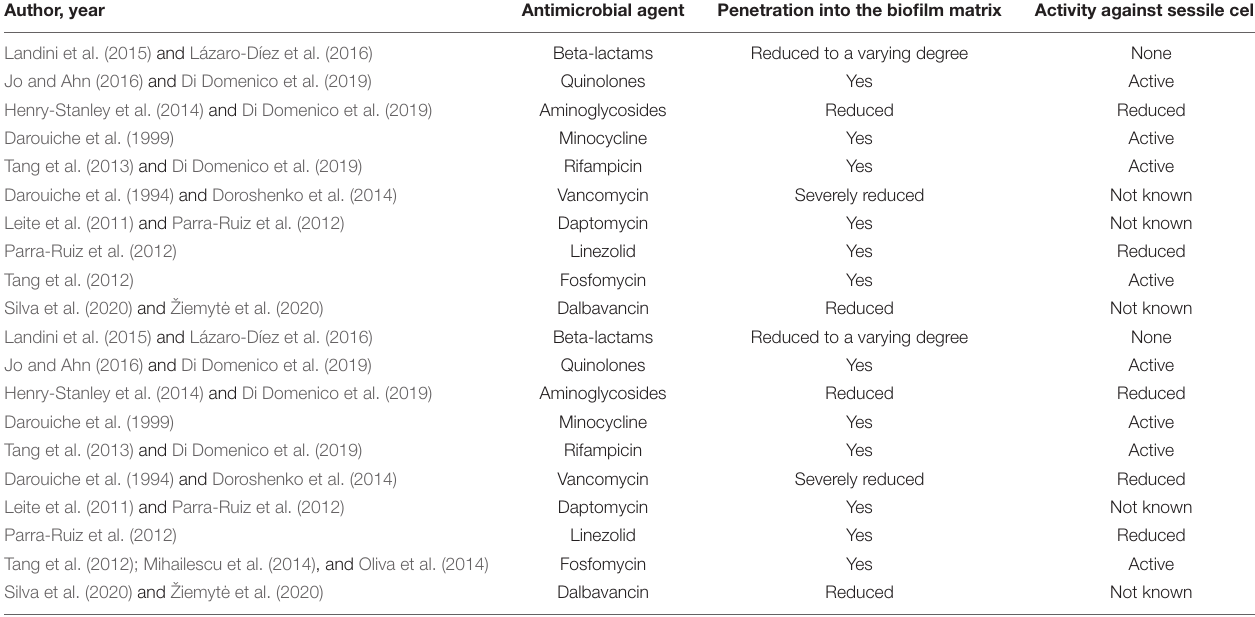
TABLE 1 | Activity of different antibiotics against biofilm-growing Gram-positive